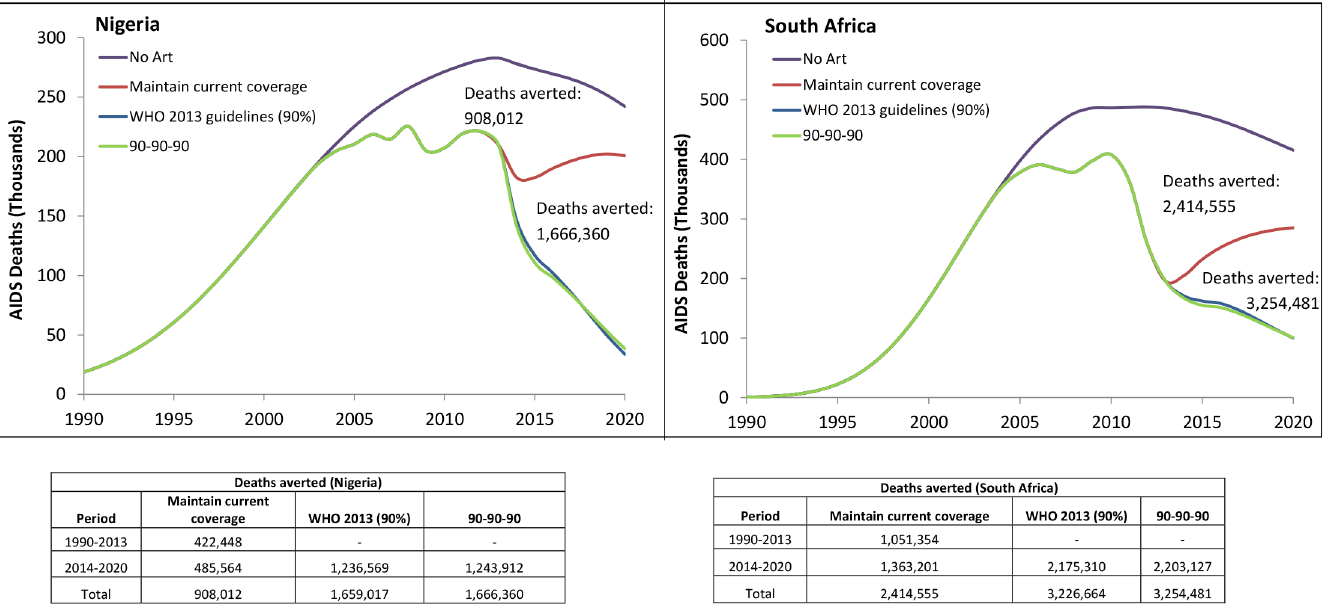
Fig 5. Projected estimated deaths averted by ART coverage scenarios for South Africa and Nigeria, 1990 – 2020. Projected deaths averted by ART expansion scenarios for South Africa and Nigeria. Reference baseline is projected deaths in the absence of ART ( No ART scenario ) which is compared to 1) maintenance of current ART coverage levels till 2020 ( Current ART Coverage scenario ); 2) expansion of access to 90% ART coverage rates of people eligible under WHO 2013 guidelines by 2020 ( 2013 WHO Guidelines scenario ) and 3) UNAIDS “ 90-90-90 ” target or 81% of people living with HIV on ART by 2020 ( 90-90-90 Scenario) . The estimated deaths averted represent the total difference from the No ART scenario .